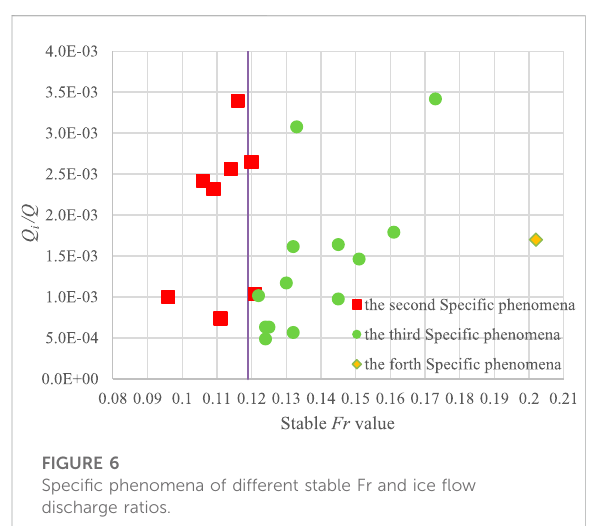
FIGURE 6 Speci fi c phenomena of different stable Fr and ice fl ow discharge